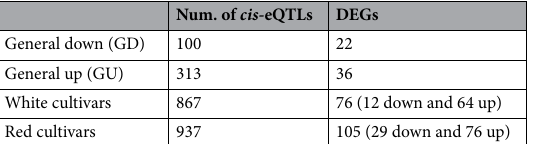
used (Supplemental Fig. S2). In the case of PV and EV comparison for red cultivars, a total of 25,087 (59.14% of 42,416 total annotated genes in grape) genes with at least one count were detected. After that, 19,379 genes with summed counts greater than 20 were retained for differential expression analysis. After, the differential expression analysis 11,899 DEGs with an adjusted p-value cutoff (FDR) < 0.05 were detected. In this final set, the total number of DEGs with a positive log2foldchange (LFC) (up) was 5903 (30%) and with a negative LFC (down) was 5996 (31%). For the target comparison (PV vs EV) in white cultivars, 25,470 (60.05% of the total annotated genes in grape) genes had at least one count and only 19,160 genes, with summed counts greater than 20, were retained for differential expression analysis. After the differential expression analysis 10,834 DEGs showed an adjusted p-value cutoff (FDR) < 0.05, with 5554 (29%) up and 5280 (28%) down. In the general study, 26,691 had at least one count, 20,621 showed more than 20 counts and were used for the expression analysis. Finally, 13,447 DEGs showed an adjusted p-value cutoff (FDR) < 0.05, with 6641 (32%) up and 6806 (33%) down regulated (Supple- mental Table S8). The obtained genotypic data and the expression data of the DEGs (up and down) identified was used as input for Matrix eQTL, to compare the selected stages (EV and PV). The number of cis -eQTL associations identified by MatrixEQTL was 2244 (2170 unique) (Supplemental Table S9). In the general eQTL analysis (using all genotypes together), 106 cis -eQTLs were identified by Matrix eQTL, associated with 22 down regulated genes (Fig. S3). In addition, 334 cis -eQTLs identified in the general analysis were associated with 36 up regulated genes (Fig. S3). For white cultivars, 867 cis -eQTLs were significant associated with 76 DEGs (Fig. S3). In the case of red cultivars, the total number of cis -eQTLs associations identified was 937 related with 105 DEGs (Table 1, Fig. S3). The inter- section of genes between categories showed that white and red cultivars shared a high number of up regulated genes (11) and only one down regulated gene. Only two genes were shared between RU, WU and GU (Fig. S4). The intersection of the results showed that 89 cis -eQTLs were unique for GD and 281 for GU. A total of 912 cis -eQTLs were unique for red cultivars and 843 cis -eQTLs unique for white cultivars (Fig. 1). Only two cis -eQTLs were shared uniquely between read and white cultivars (NC_012020.3_22792433_4612345,